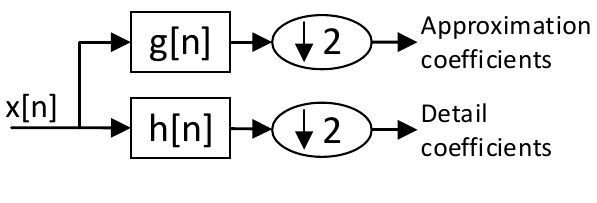
Figure 2. Block diagram of the proposed method.